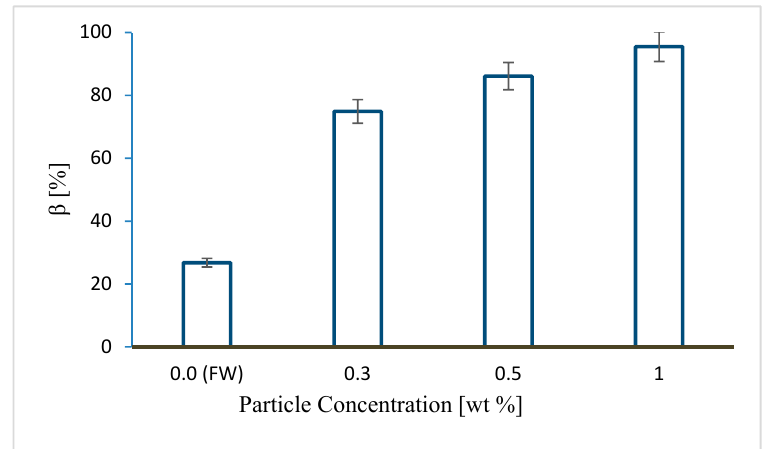
Figure 8. The relative impact of fines mobilization and salt precipitation on CO 2 injectivity. Fines migration had a more severe impact on injectivity compared to salt precipitation.